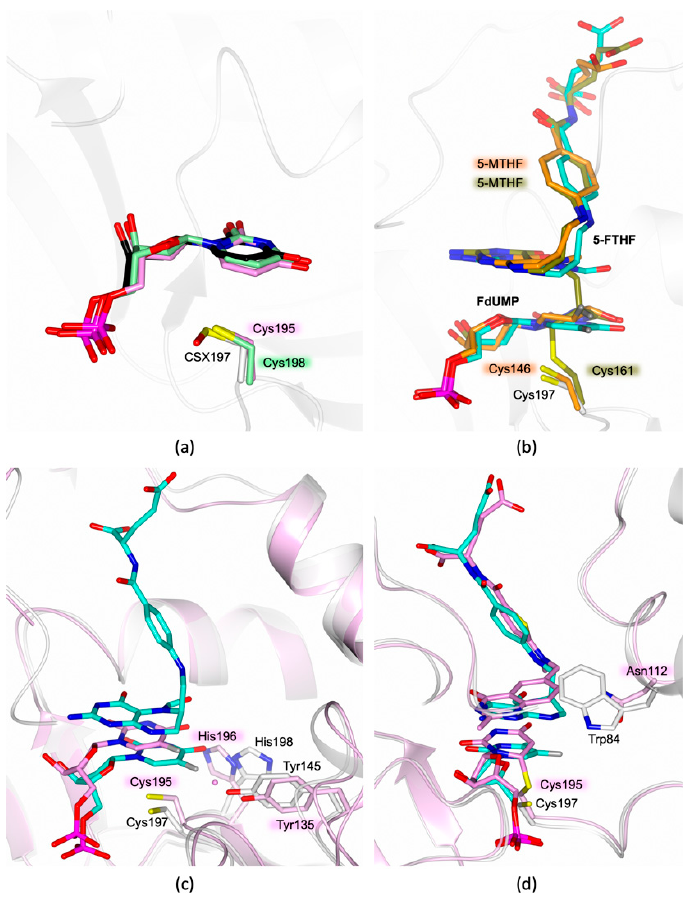
Figure 7. Active site view of the superimposition among the complexes: ( a ) Ef TS–dUMP (CSX197 in sticks, white carbon atoms; dUMP in sticks, black carbons), Lc TS–dUMP (in sticks, light green carbons; PDB id 2TDM [21]), and hTS–dUMP (in sticks, pink carbons). ( b ) Ef TS–FdUMP–5-FTHF (Cys197 in sticks, white carbon atoms; ligands in sticks, cyan carbons), Mtb TS–FdUMP–5-methyl-THF (in sticks, orange carbons; PDB id 4FOG, unpublished results), and Bs TS–FdUMP–5-methyl-THF (in sticks, olive carbons; PDB id 1B02 [22]). ( c ) Ef TS–FdUMP–5-FTHF (white cartoon, Cys197 in sticks, white carbon atoms; ligands in sticks, cyan carbons) and hTS–FdUMP (pink cartoon and carbon atoms). ( d ) Ef TS–FdUMP–5-FTHF (white cartoons, Cys197 white carbon atoms; ligands in sticks, cyan carbons) and hTS–dUMP–raltitrexed (pink cartoon and carbon atoms). In the ( a ) and ( b ) panels, only the catalytic cysteine is shown in the structures of Lc TS, hTS, Mtb TS, and Bs TS for clarity.